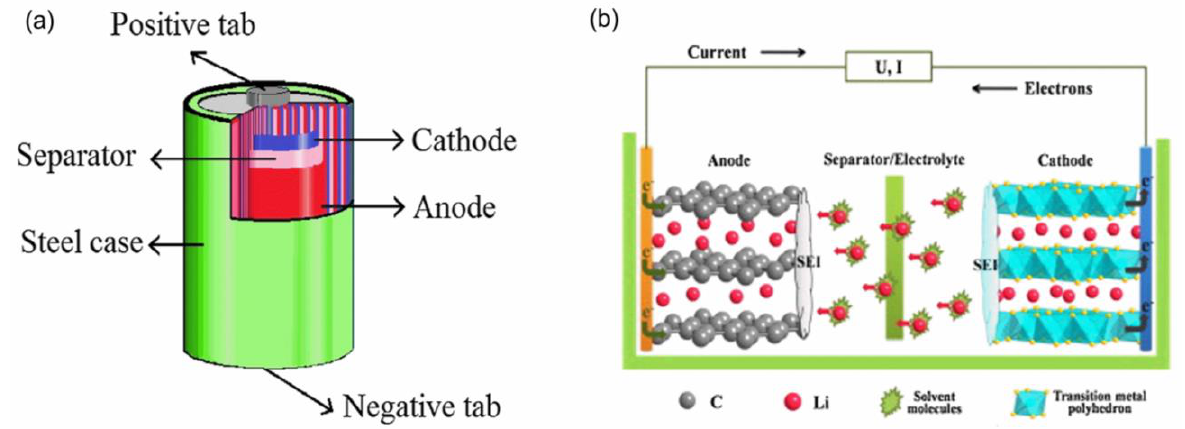
Figure 1. ( a ) Components and ( b ) working principles of LIBs. Reprinted with permission from ref [26,27].